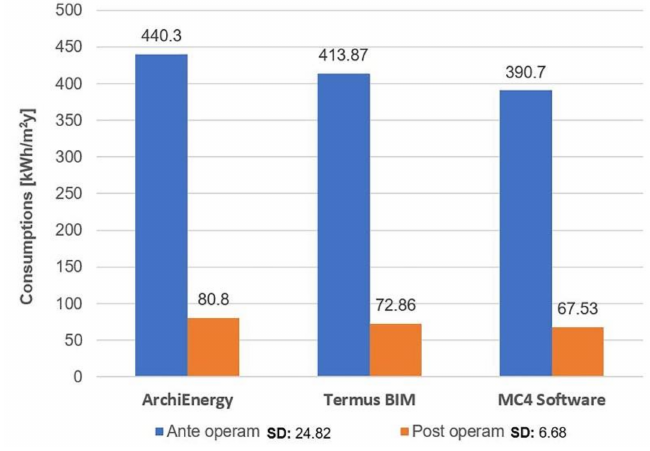
Figure 15. Software comparison through energy diagnosis results on similar buildings.